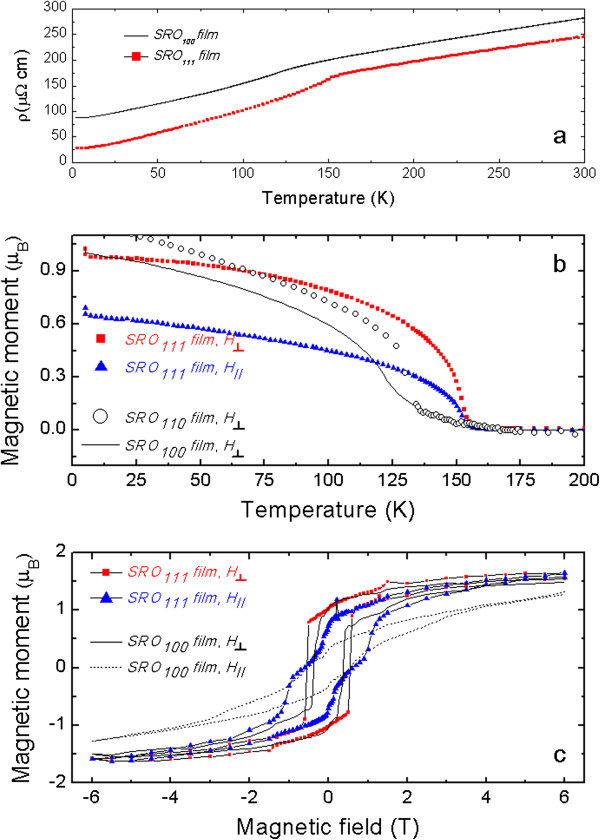
Transport and magnetic properties of SrRuO3/SrTiO3 (001) and SrRuO3/SrTiO3 (111). For SrRuO3/SrTiO3 (111), magnetization was measured in two field directions with respect to the substrate: surface normal and in-plane directions. (a) Resistivity curves. (b) Magnetization curves together with those of SrRuO3 films on SrTiO3 (001) and STO (110) substrates reported by Jung et al. [7]. (c) Magnetic hysteresis curves at 5 K.